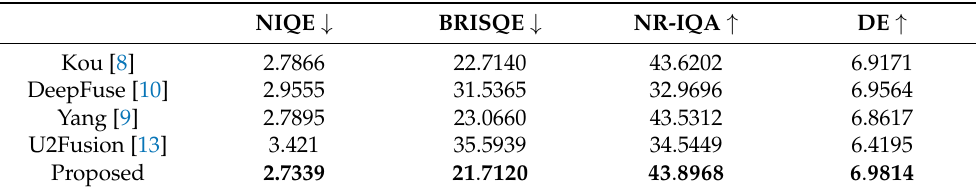
Table 1. Quantitative comparisons of different fusion methods. The scores are averaged over all of the test images. The values in bold represent the best scores.